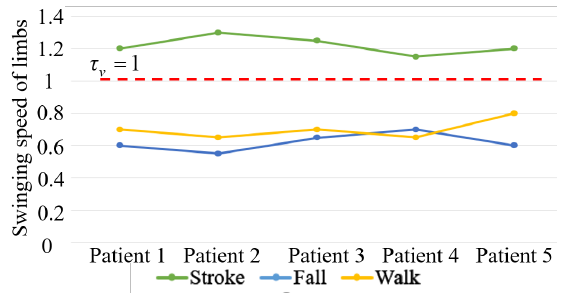
Fig. 5. Selection of threshold value for limb swing speed.